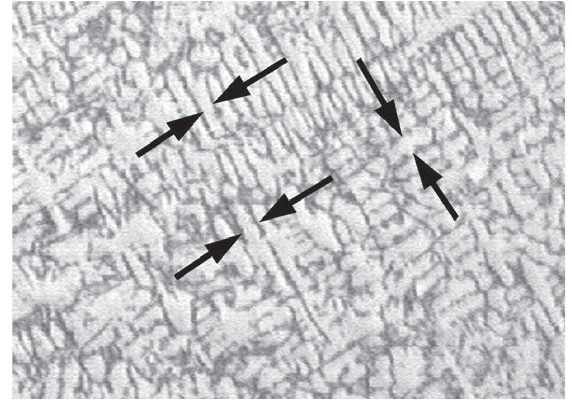
Figure 4. Photomicrography showing the dendritic cell measure- ments given in Table